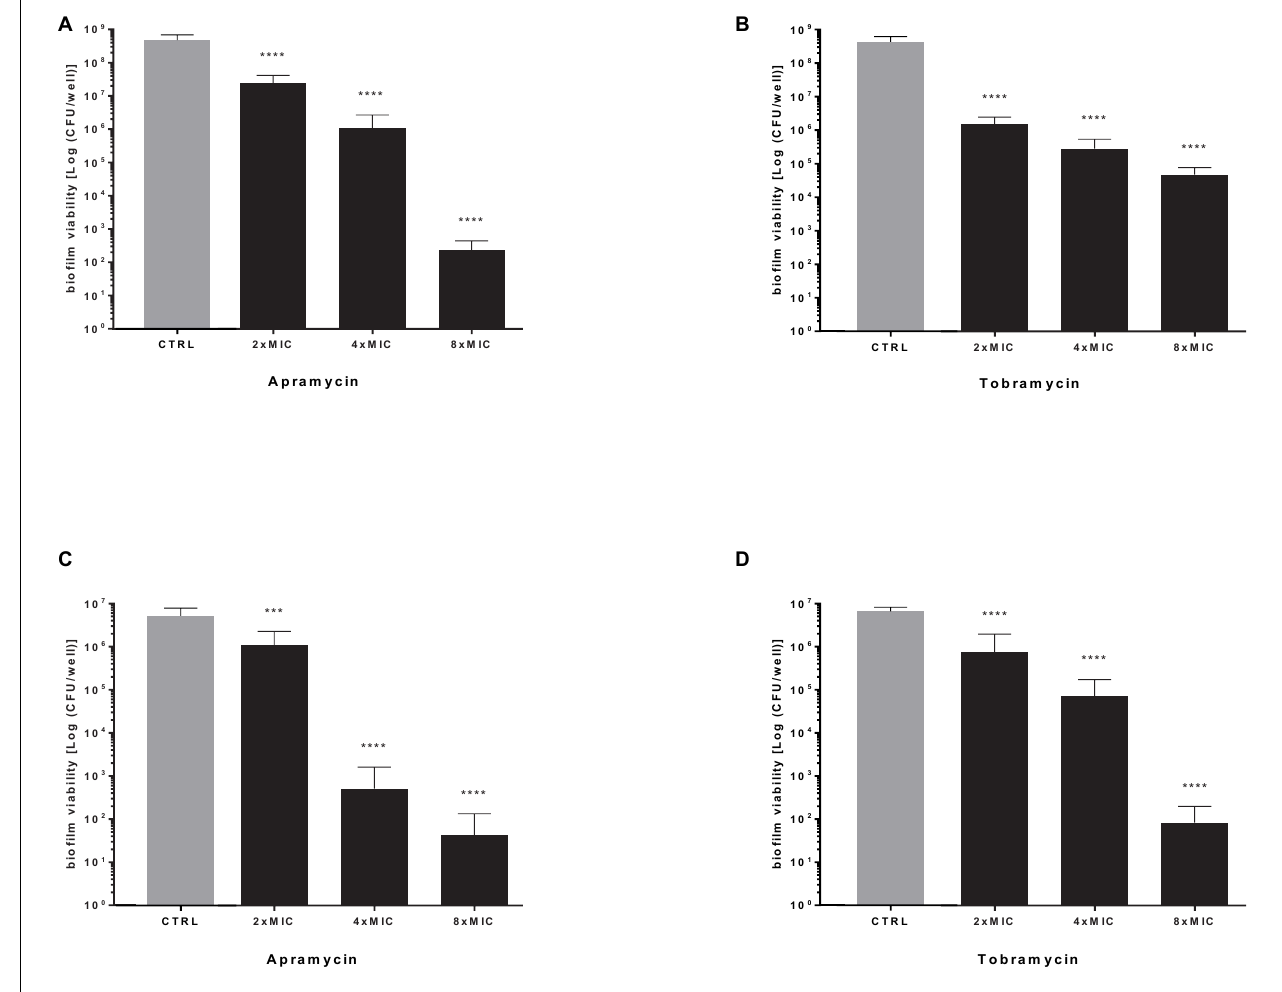
FIGURE 5 | Killing activity against preformed P. aeruginosa biofilm. The efficacy of apramycin and tobramycin on the viability of 24 h-mature biofilm by P. aeruginosa Pa7 (A,B) and PaPh32 (C,D) was assessed by viable cell count assay. Each drug was tested at multiples of MIC value. Results are expressed as mean + SD of the residual biofilm viability [Log (CFU/well)] after 24 h-exposure. Control samples (CTRL) were not exposed to drug. Statistical significance at ordinary one-way ANOVA followed by Holm-Sidak’s multiple comparisons post-test: *** p < 0.001, **** p < 0.0001 vs.